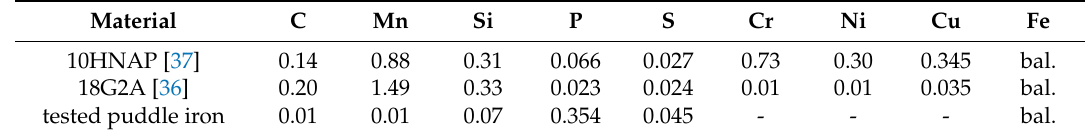
Table 2. Static mechanical properties of the analyzed metallic materials.